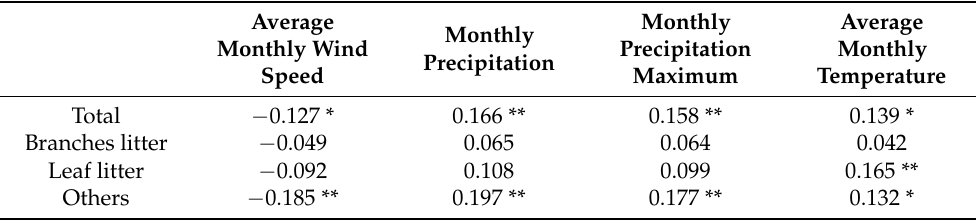
Table 3. Correlation coefficients between litterfall productions of different components and various meteorological factors.